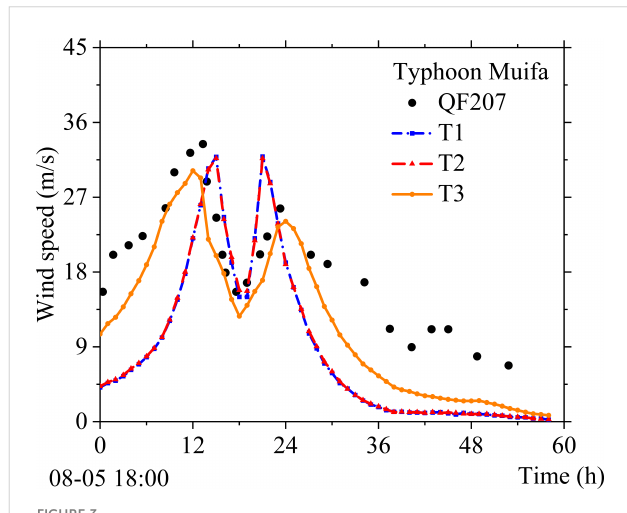
FIGURE 3 The modeled and buoy station observed wind